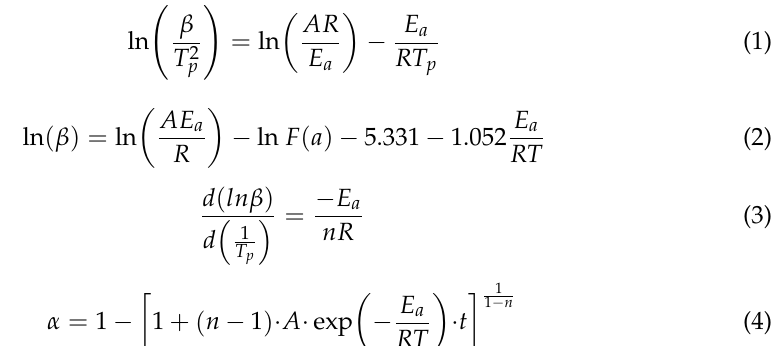
The linear relation between 1/ T p and ln( β ) was obtained, and the E a value was calculated to be 70.25 KJ/mol from the slope of the line.